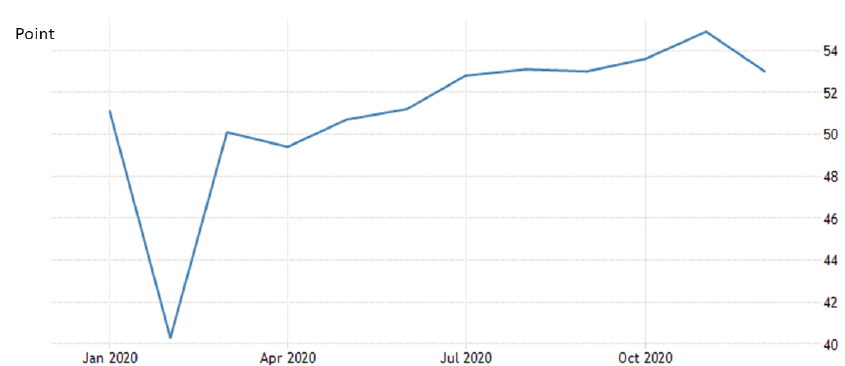
Figure 4. Changes in PMI in China during the COVID-19 pandemic [21].